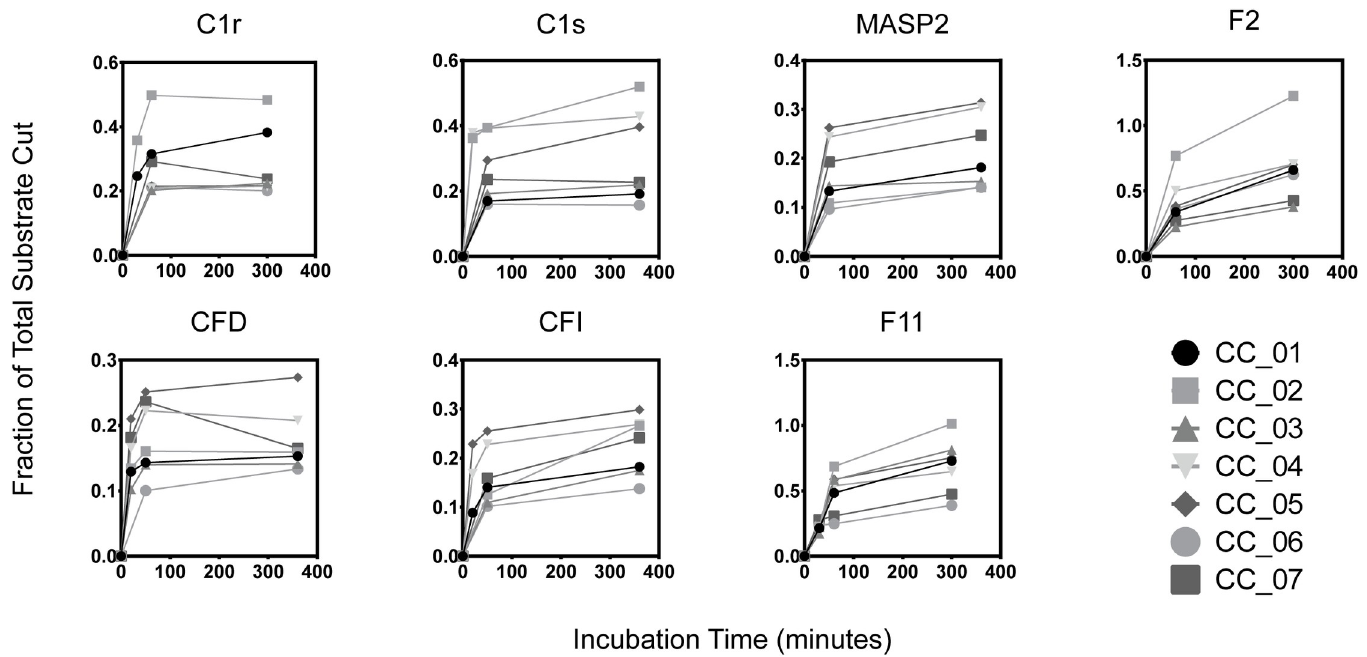
Fig 1. Recombinant protease cleavage assays of seven complement and coagulation cascade proteins. From left to right, top to bottom, abbreviations are: Complement proteins C1r and C1s, MASP2, Coagulation Factor IIa, Complement Factor D, Complement Factor I, and Coagulation Factor XIa. Each trace represents a different peptide substrate (CC01–07).